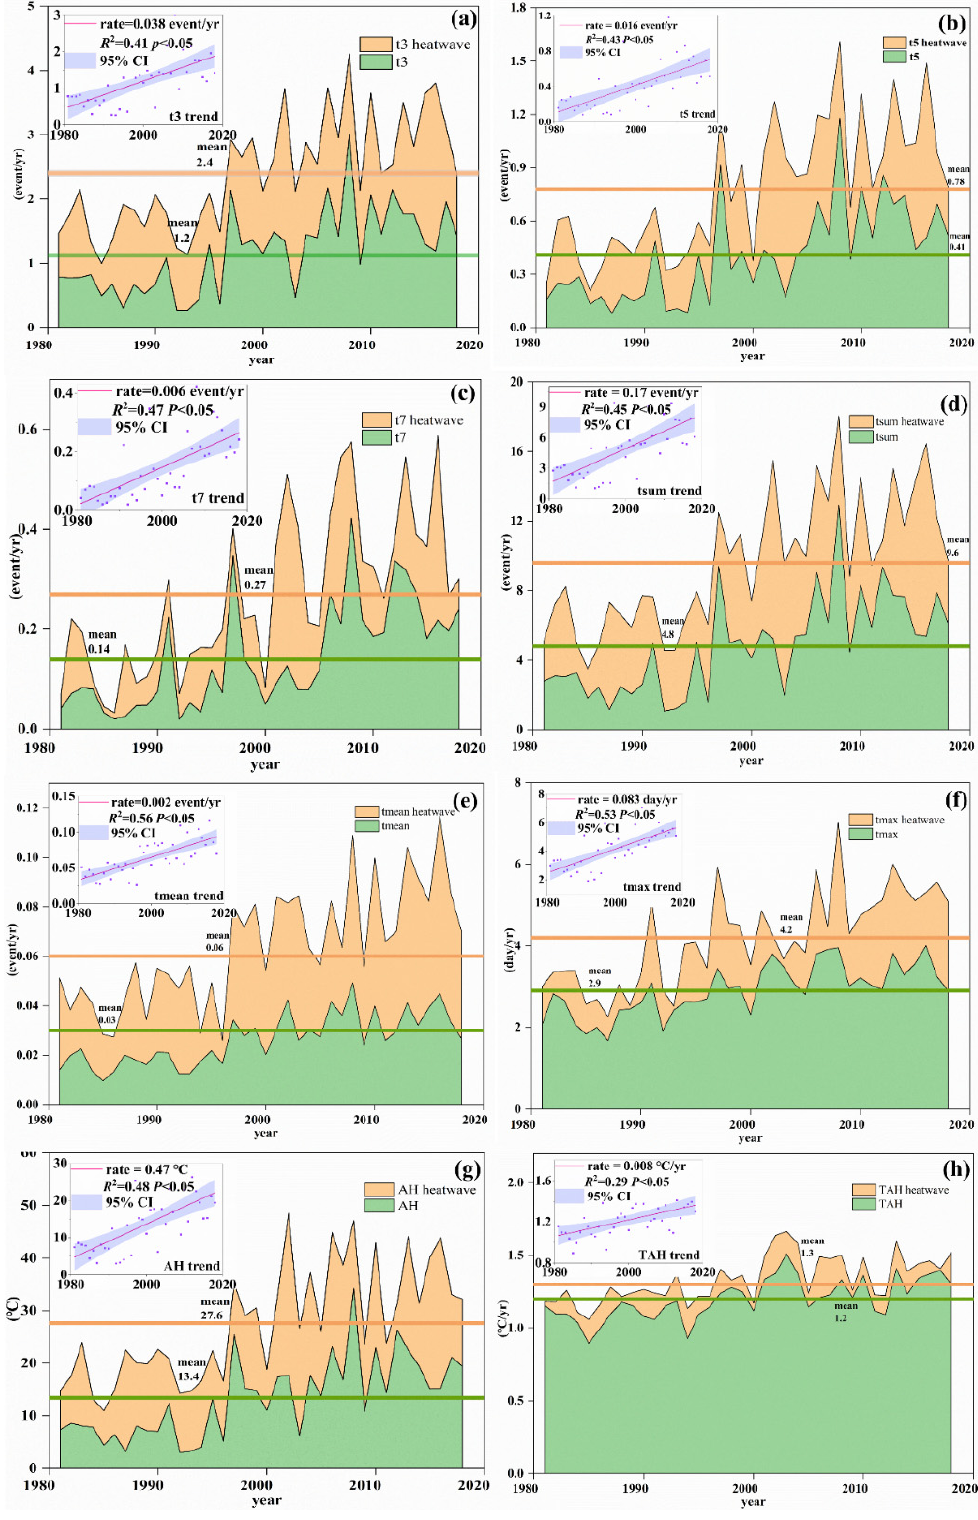
Figure 4. ( a – h ) Time trend and significance test for each CDHW index in Central Asia. Note: The orange area represents the occurrence of all heatwave days, and the green area represents the occurrence of heatwaves under drought